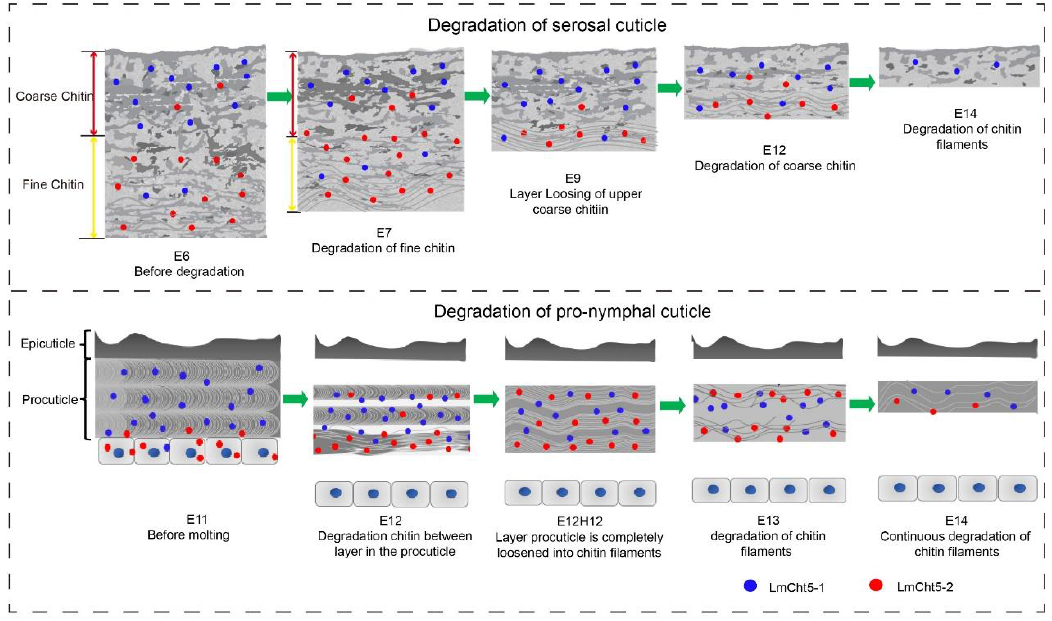
Figure 6. Hypothesis of function of chitinase on chitin degradation in cuticle layers. The degradation of chitin in the cuticle layer is at least two steps. First, the layer connection is loosened by chitinase ( LmCht5-1 ) and some unknown hydrolysis X. Then, the chitin inside the layer degrades into filaments mainly by chitinase ( LmCht5-2 ) and some unknown hydrolysis Y.